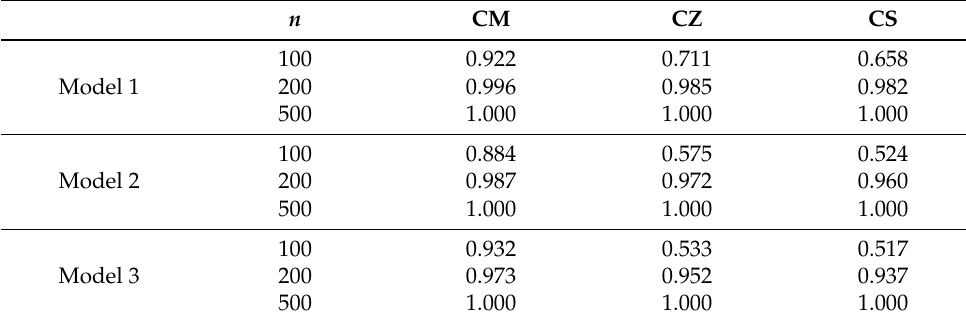
Table 4. CM, CZ, and CS for Models